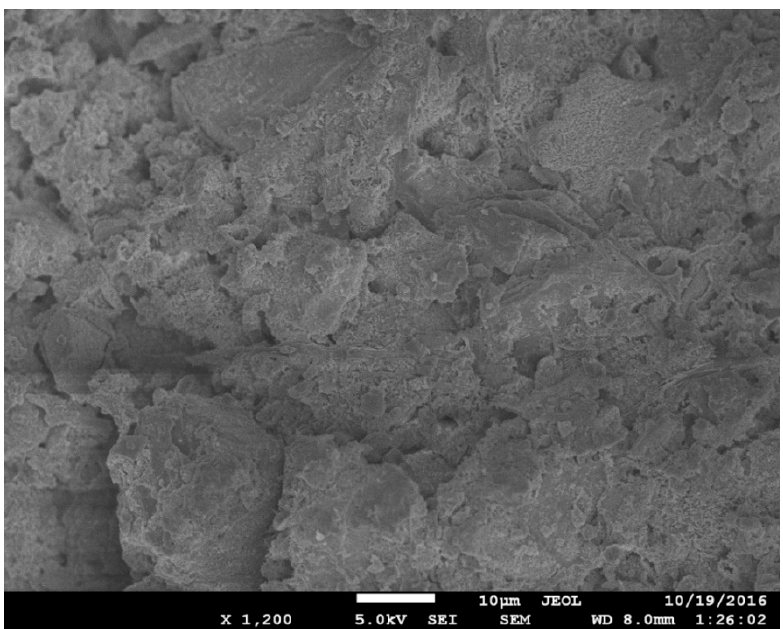
Figure 9. Microstructural image of concrete Mix 4.